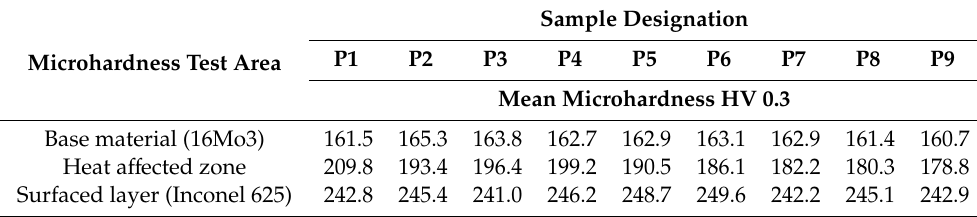
Table 10. Average microhardness HV0.3 measured on the cross-section of 16Mo3 steel pipes plasma clad with Inconel 625 superalloy powder (Table 6).